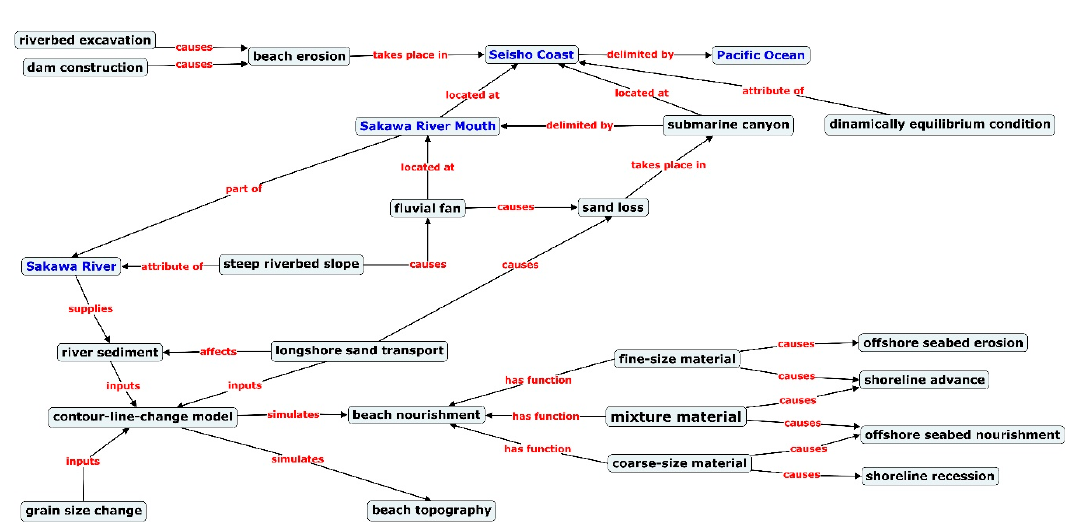
Figure 5. Semantic network of the terms associated with the Sakawa River .